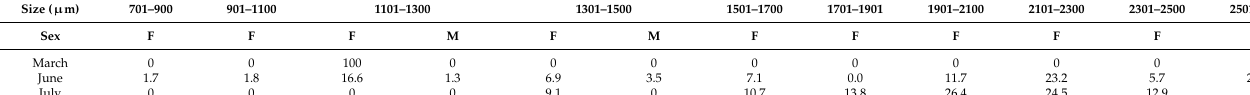
Figure 2. Biomass contribution of the main groups of the zooplankton community during the study period.